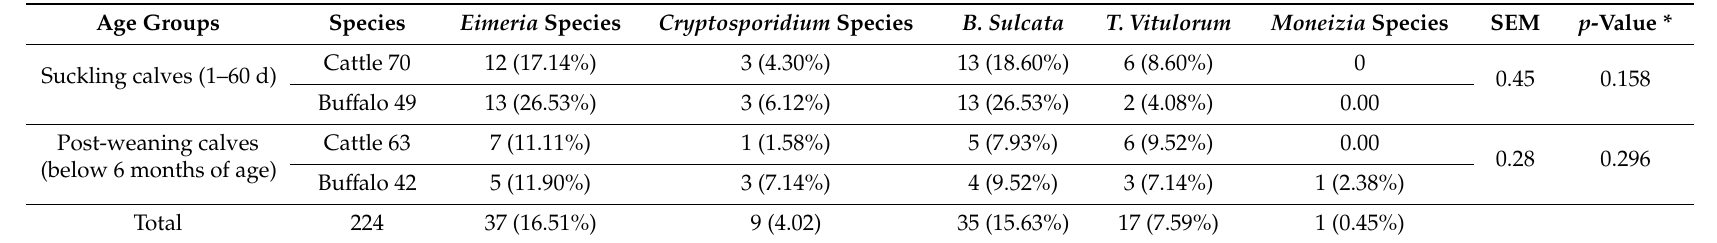
Table 3. Prevalence rate of mono-infections in diarrheic calves.